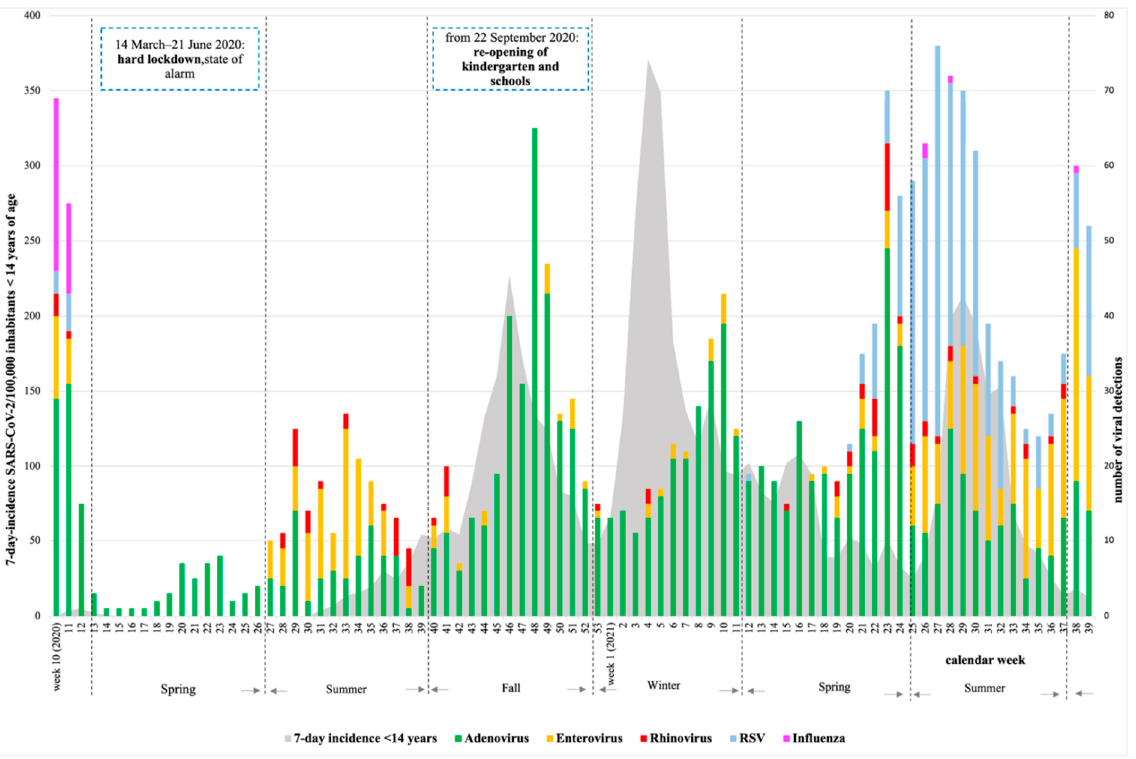
Figure 2. Detection of respiratory viruses among 14,640 collected swabs from week 10, 2020 to week 39, 2021 in Asturias. Depicted in gray is the 7-day-incidence SARS-CoV-2 in children under 14 years per 100,000 inhabitants in Asturias (https://obsaludasturias.com/obsa/niveles-covid-19/) (accessed on 8 June 2022).